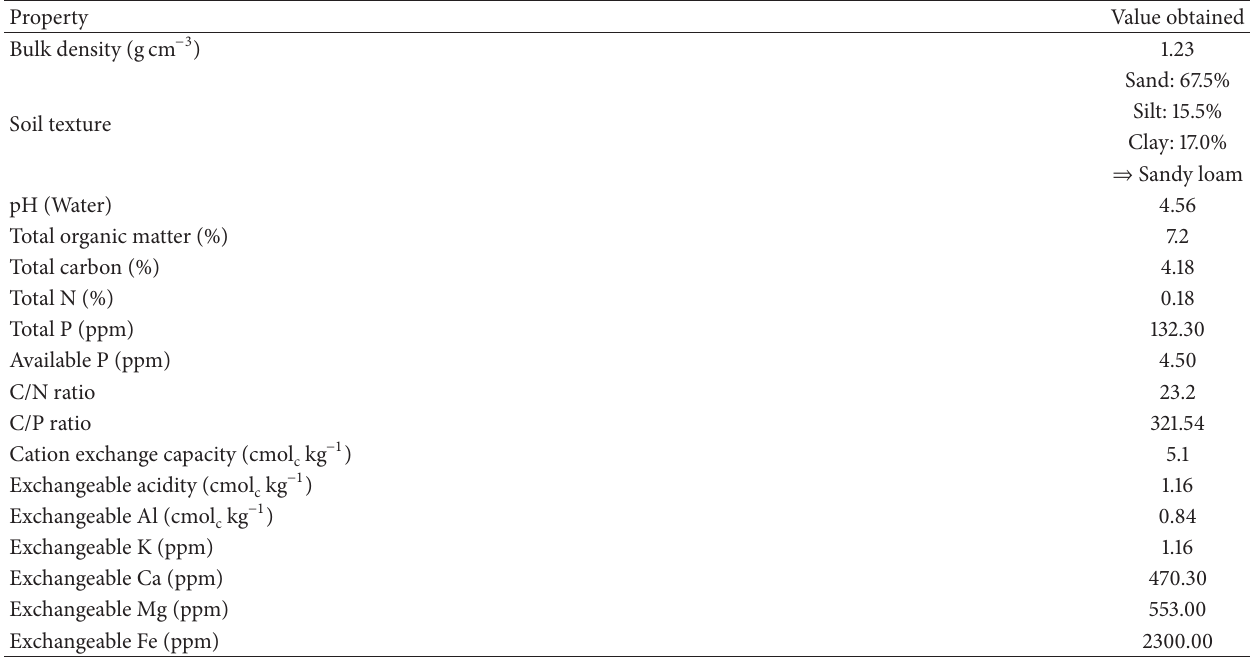
Table 1: Selected physicochemical properties of Bekenu series soil.